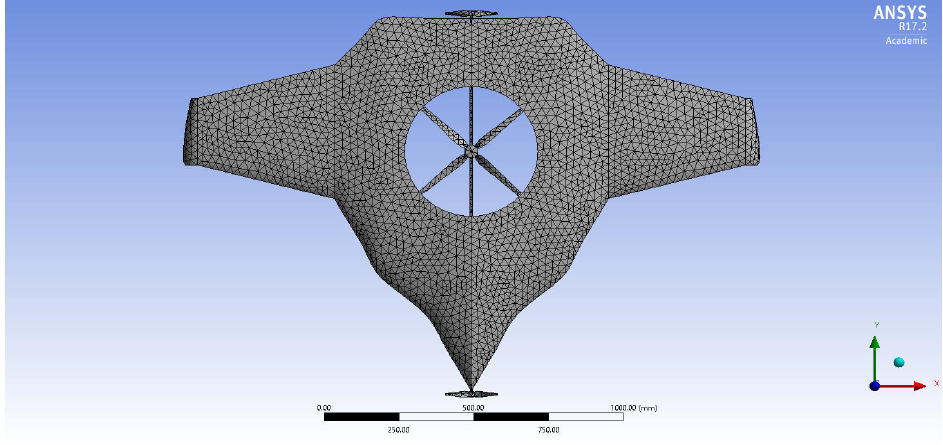
Figure 4. Mesh of Version II of BWB-UAV.